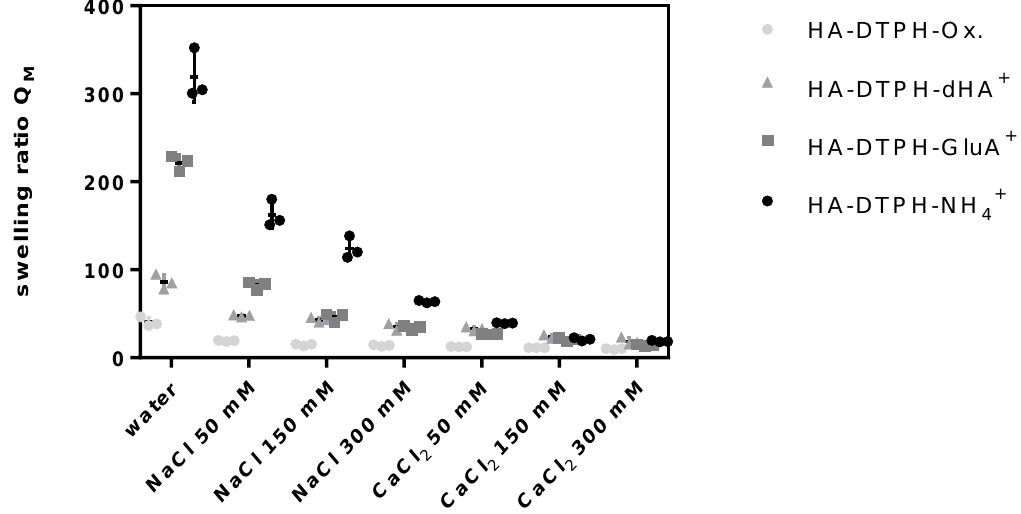
Figure 4. Swelling ratio of HA-DTPH 29% -Cl + hydrogel and HA-DTPH 29% -Ox. In water and changing ionic strength and ions.